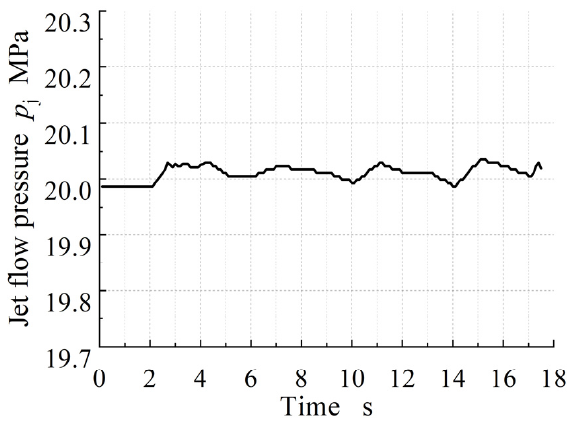
Figure 5. Monitoring data of jet pressure.